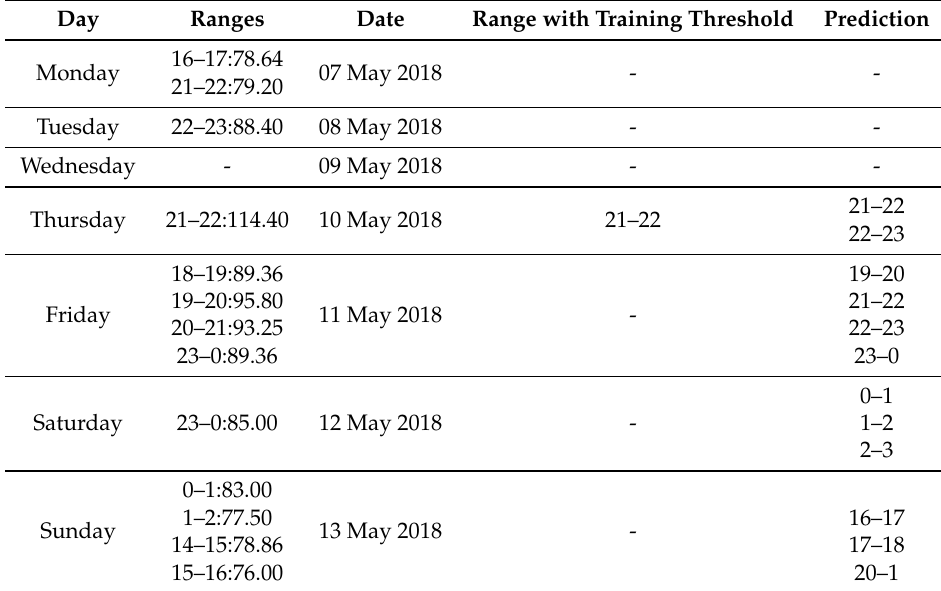
Table 8. Validation week 2 from 7 to 13